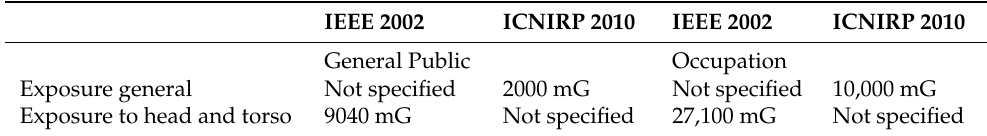
Table 3. ICNIRP and IEEE electromagnetic exposure